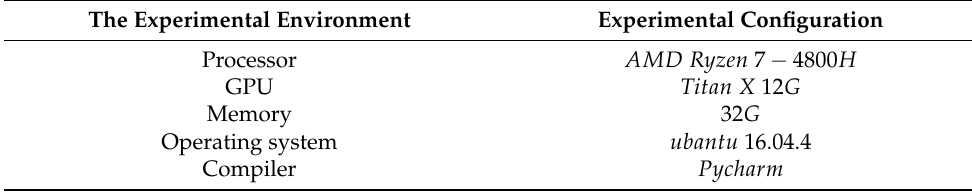
Table 3. The experimental environment.